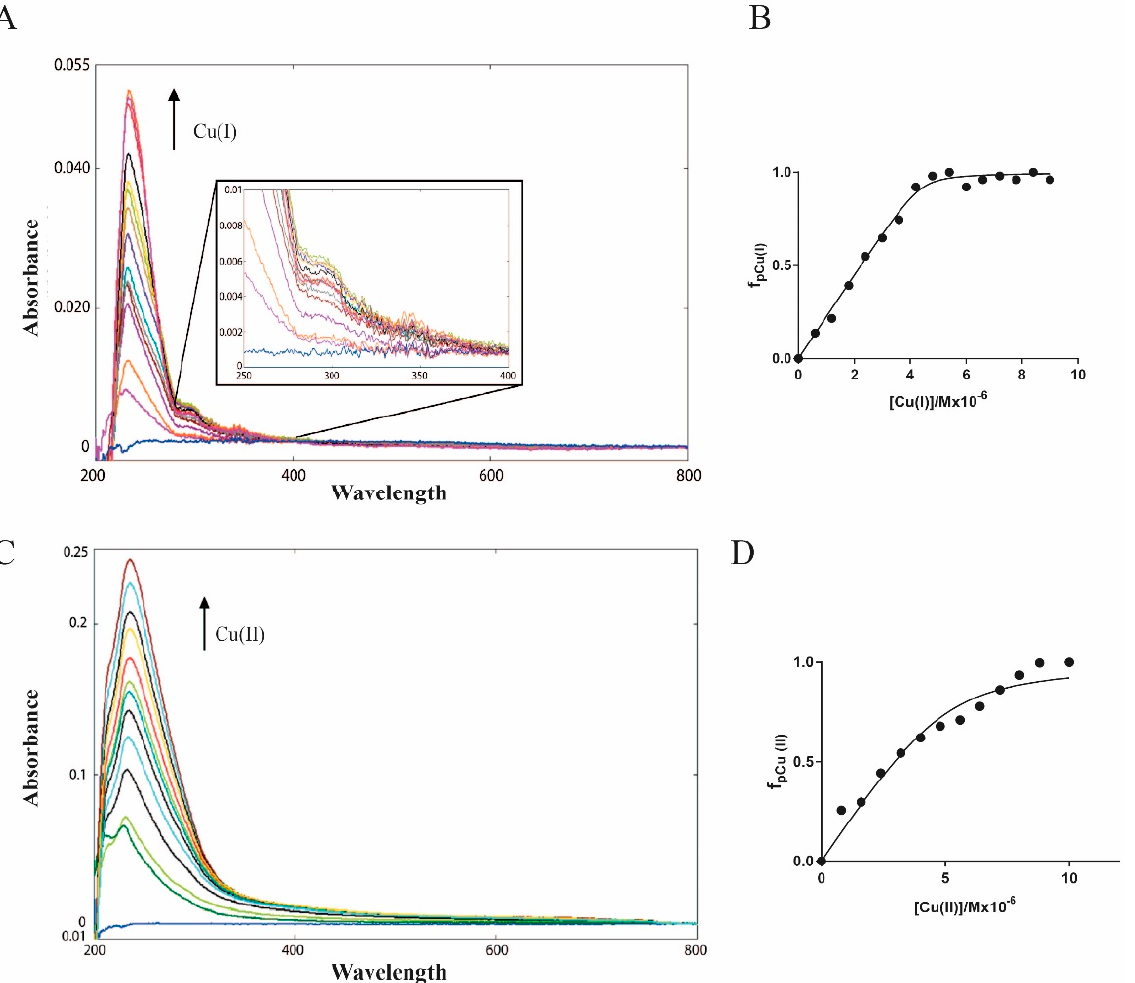
Figure 2. UV-Vis spectra of Apo-Ros87 with ( A ) Cu(I) and ( C ) Cu(II), respectively; fitting curves for ( B ) Cu(I)-Ros87 and ( D ) Cu(II)-Ros87. Furthermore, the Cu(I)-Ros87 (1.8:1 ratio) solution was retro-titrated with a solution of Zn(II) (Figure S1A) and the disappearance of the band at 263 was followed. The apparent dissociation constant for Zn(II)-Ros87 (4.2 ( ± 0.45) × 10 − 10 M) was calculated and gave val- ues similar to those already published [32]. The direct titration of Apo-Ros87 with Cu(II) is reported in Figure 2C together with the plot of absorbance versus the concentration of Cu(II) (panel D). In this case, the band at 236 nm, typical of a coordination of this metal ion to the histidine imidazole (LMCT Cu(II)-Im [46], was followed that clearly indicates the formation of a complex with a 1:1 stoichiometry and gave a calculated Kd* = 4.5 ( ± 0.9) × 10 − 7 M. Also in this case, Cu(II)-Ros87 (1.8:1) solution was retro-titrated with a solution of Zn 2+ (Figure S1B) and the disappearance of the band at 236 was followed. The apparent disso- ciation constant for Zn(II)-Ros87 (8.3 ( ± 0.96) × 10 − 10 M) was calculated and gave values similar to those already published (5.8 × 10 − 10 ). Copper, in both oxidation states, is capable of binding Ros87 with a good affinity that is at least two orders of magnitude lower compared to the affinity for its wildtype zinc